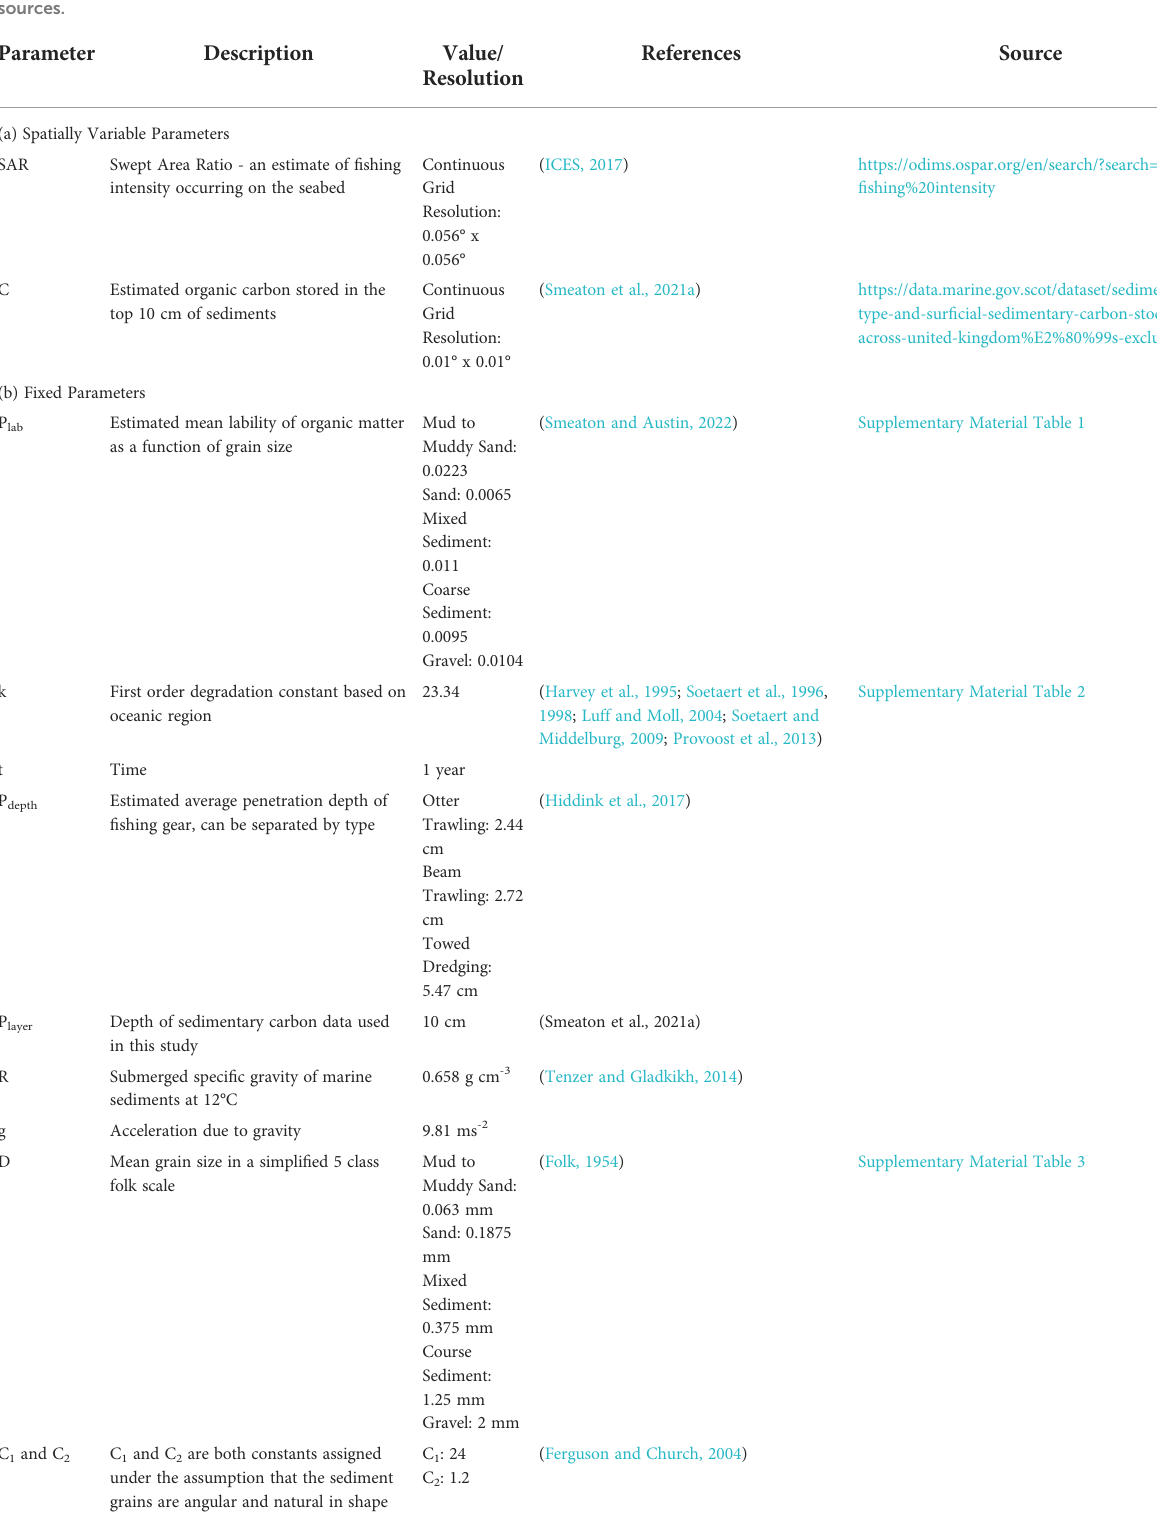
TABLE 1 Parameters used for modelling the potential vulnerability of UK EEZ marine sediments under different fi shing gear types and their